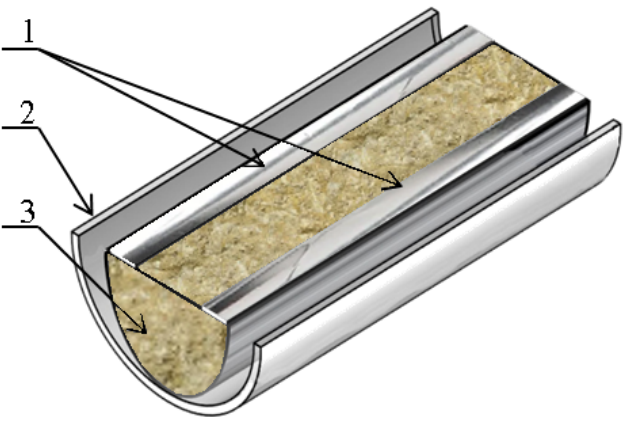
Figure 4. Core sample preparation. 1, aluminum foil strips; 2, the plastic heat shrink sleeve; 3, natural core sample.